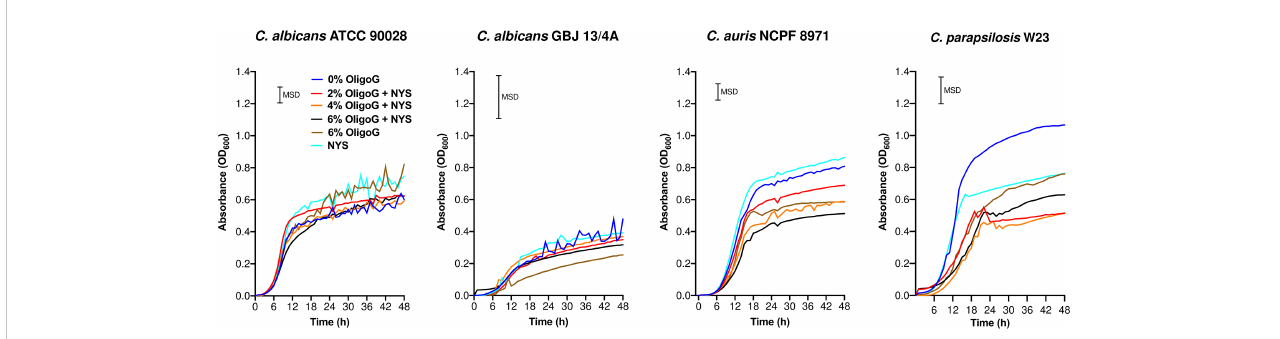
FIGURE 1 Growth curves for Candida spp. treated with OligoG (2, 4 and 6%) in combination with nystatin (NYS; at ½ MIC; 1-2 µg/ml). Minimum signi fi cant difference (MSD) for absorbance was calculated in MiniTab using the Tukey-Kramer method (n=3): C. albicans ATCC 90028 (MSD=0.12), C. albicans GBJ 13/4A (MSD=0.32), C. auris NCPF 8971 (MSD=0.12) and C. parapsilosis W23 (MSD=